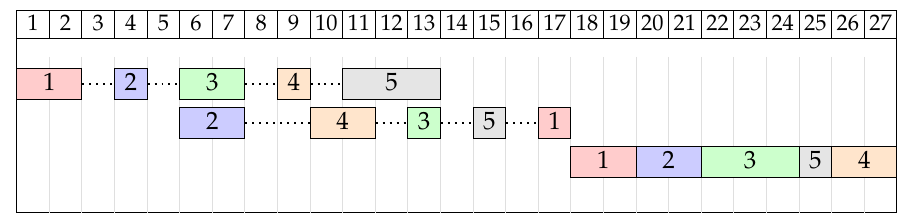
Figure 1. The left-shifted schedule for the instance from Example 1 and π = (( 1,2,3,4,5 ) , ( 2,4,3,5,1 ) , ( 1,2,3,5,4 ))